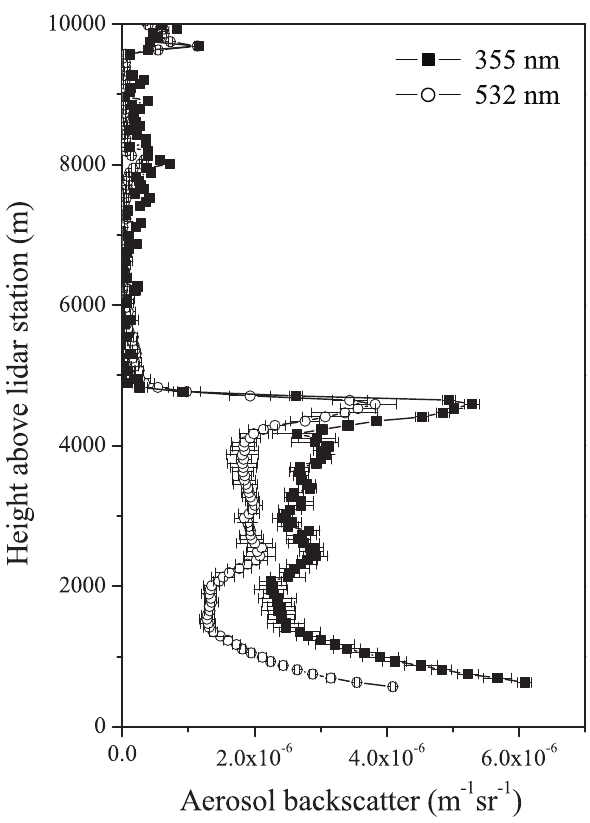
Fig. 4. Vertical profi les of the aerosol backscatter at both 355 nm (solid squares) and 532 nm (open cir- cles) measured in tito Scalo on 31 August 2000 (19: 20 - 19:50